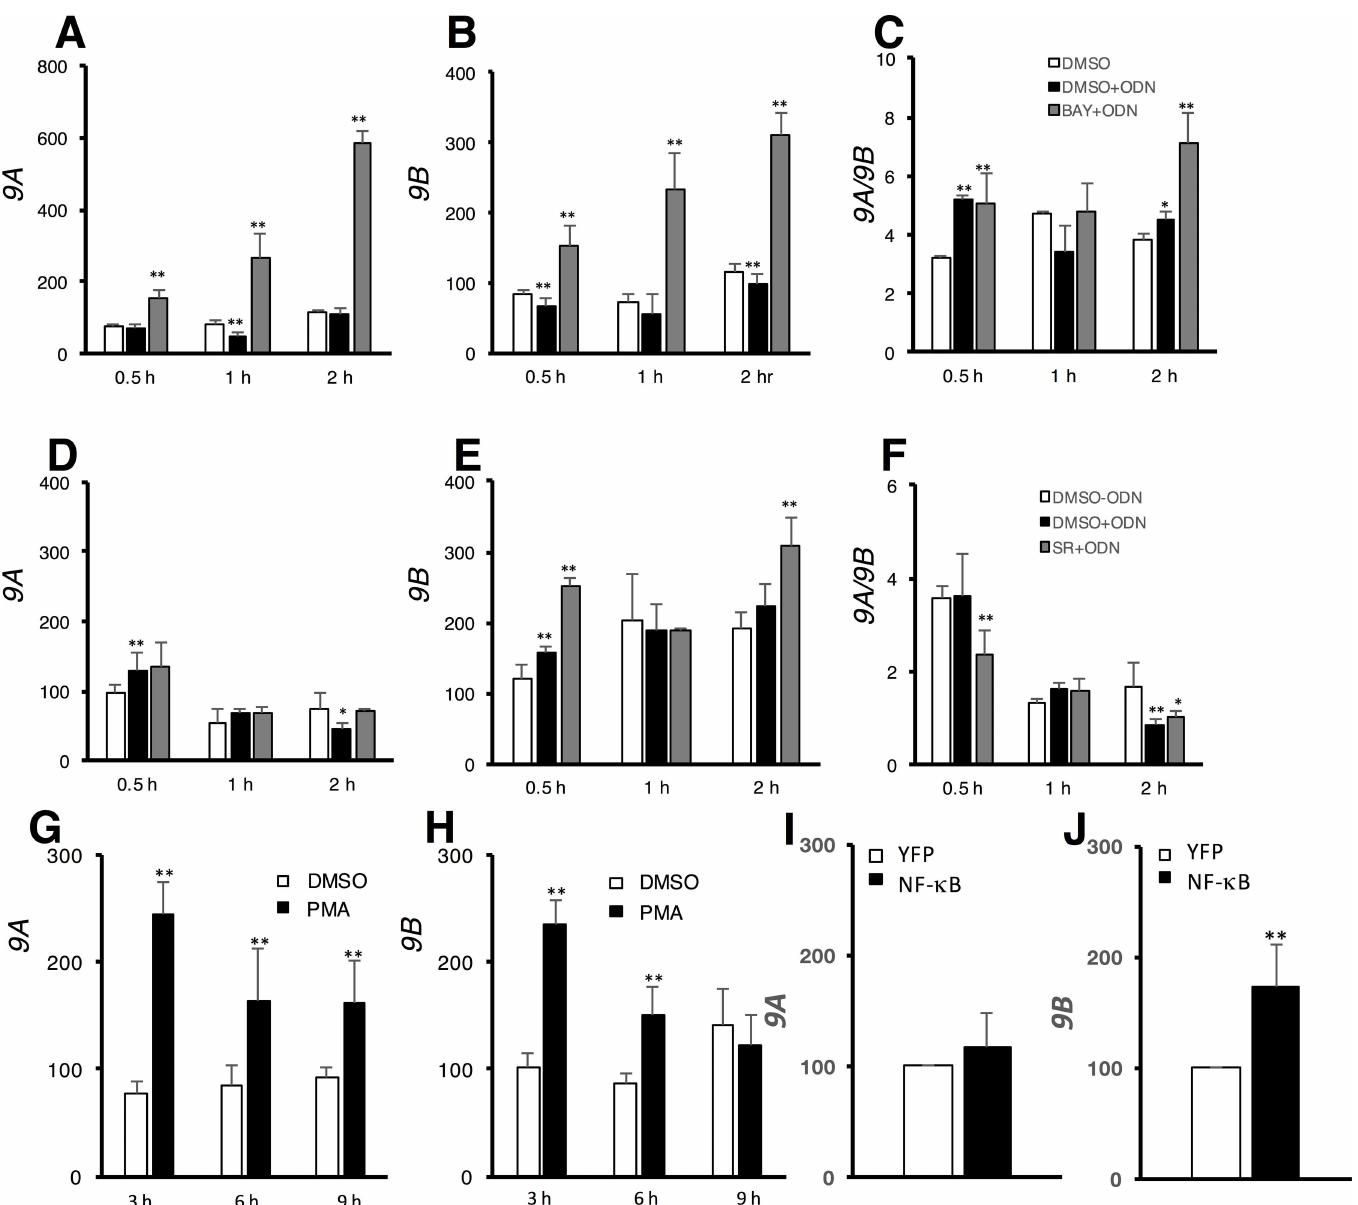
Fig 2. NF- κ B regulates gTlr9 alternative splicing. Two inhibitors BAY and SR, which targeted either NF- κ B or AP-1 transcription factors, respectively, were appliedunder CpG ODN stimulation. The inhibitionof one transcription factor under stimulation would result in activation of the other (see text for details). The expression of either 9A or 9B were determinedby RT-qPCR and normalized against that of ß-actin as in Fig 1. Inhibitionof NF- κ B under ODN stimulation showed elevated 9A , 9B and 9A/9B ratio (gray bars in each panel) ( 2A-C ). In contrast, inhibitionof AP-1 under stimulation selectivelyincreased the expression of 9B only, thus decreased 9A / 9B ratio (gray bars in each panel) ( 2D-F ). ( 2G-H ) Both 9A and 9B expressionlevel increasedin GK cells stimulated with PMA. ( 2I - J) YFP and YFP-tagged NF- κ B were transfected into GK cells. 24 hours after transfection, relative expressionof both 9A and 9B were assayed by RT-qPCR. The expression of 9A remained largelythe same (I), but 9B expressionincreasedas compared to YFP vector control (J). Results are presented as the mean ± SD (n = 3). Student’s t-test, 0.01 < p < 0.05 ( * ) and p < 0.01 ( **